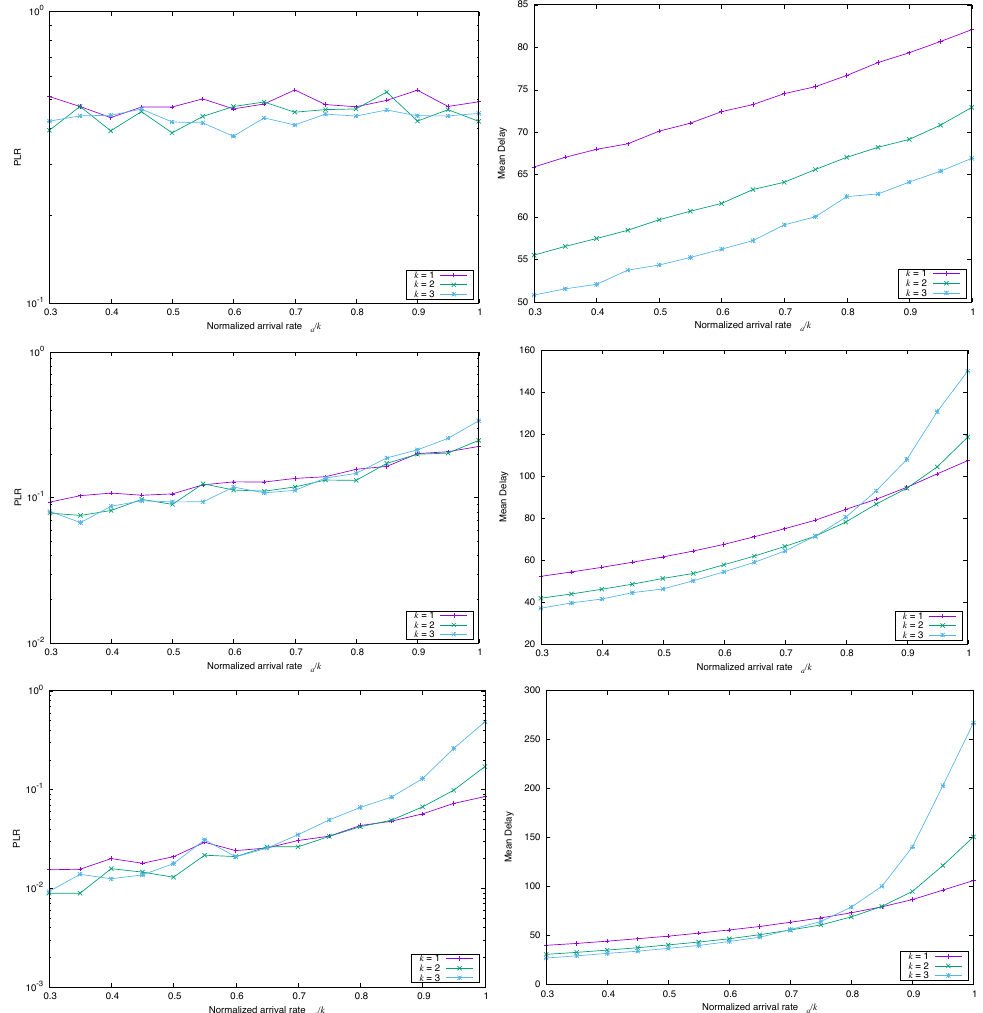
Figure 10. Simulated PLR ( left ) and Mean Delay ( right ) for FA-CSA versus λ a / k , with Λ ( x ) = 0.86 x 3 + 0.14 x 8 , n = 200 and k = { 1,2,3 } , and marginal distribution Pareto, with α = 1.1 ( top ), α = 1.5 ( middle ), and α = 1.9